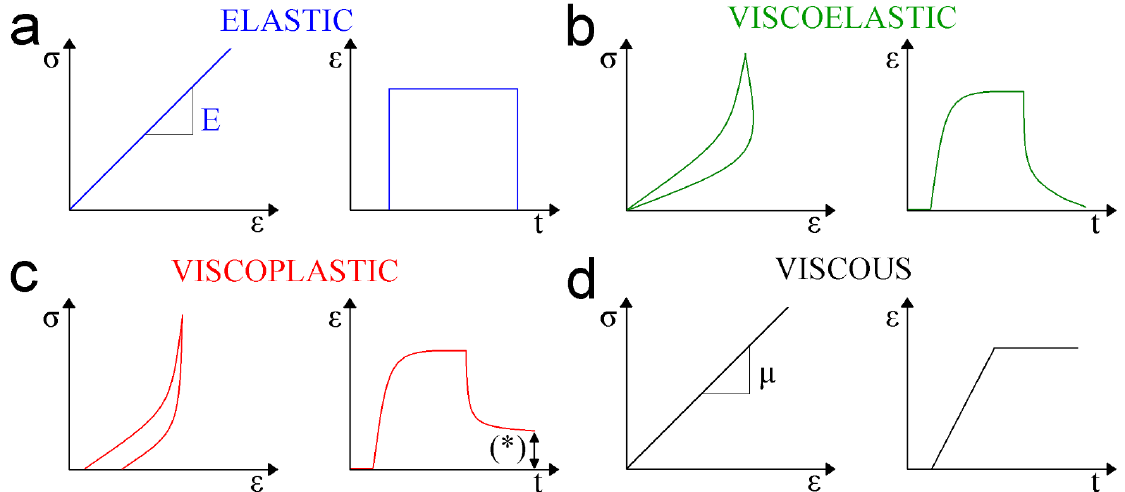
Figure 1. Schematic representation of ( a ) elastic, ( b ) viscoelastic, ( c ) viscoplastic and ( d ) viscous mechanical properties characterization. The left-hand plot depicts stress ( σ )–strain ( ε ) relationships for all types of soft matter biomechanics. The slopes obtained in the elastic and viscous solids represent the Young’s modulus (E) and viscosity ( µ ) of the material, respectively, whereas the right- hand plot illustrates the respective correspondence between strain ( ε ) and time (t) for each mechanical performance above described. (*) corresponds to residual strain not recovered in those viscoplastic deformation